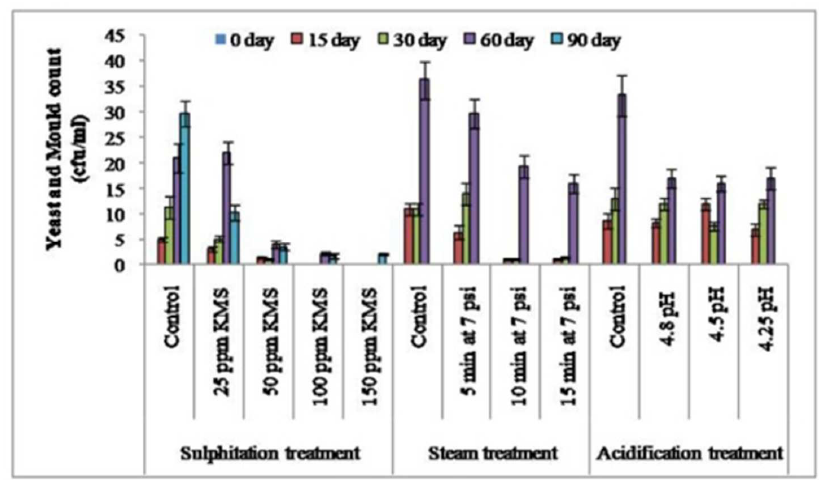
Figure 3. Effect of sulphitation, steam treatment, and acidification on yeast and mold count during storage of sugarcane juice at refrigerator temperature.